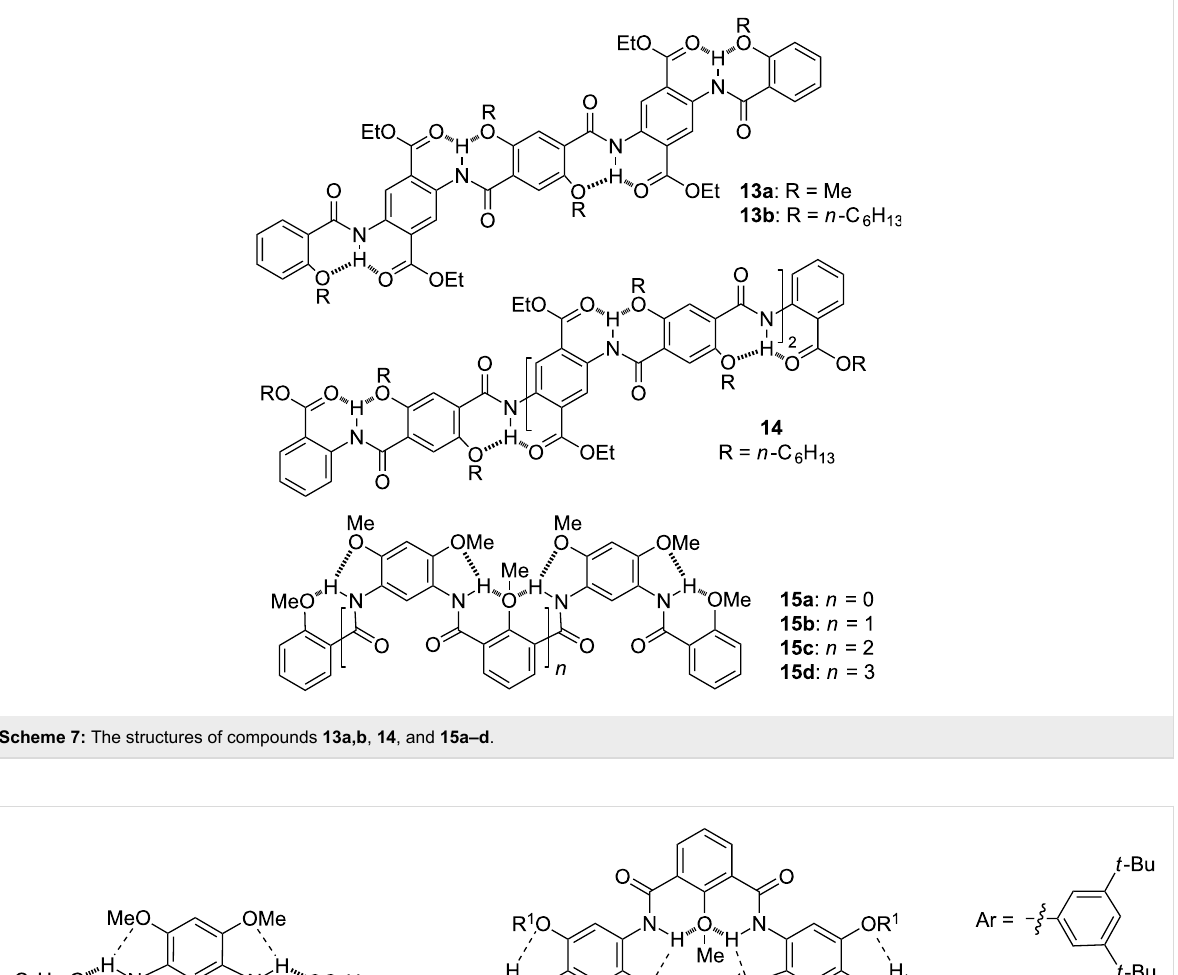
Scheme 7: The structures of compounds 13a,b , 14 , and 15a–d .